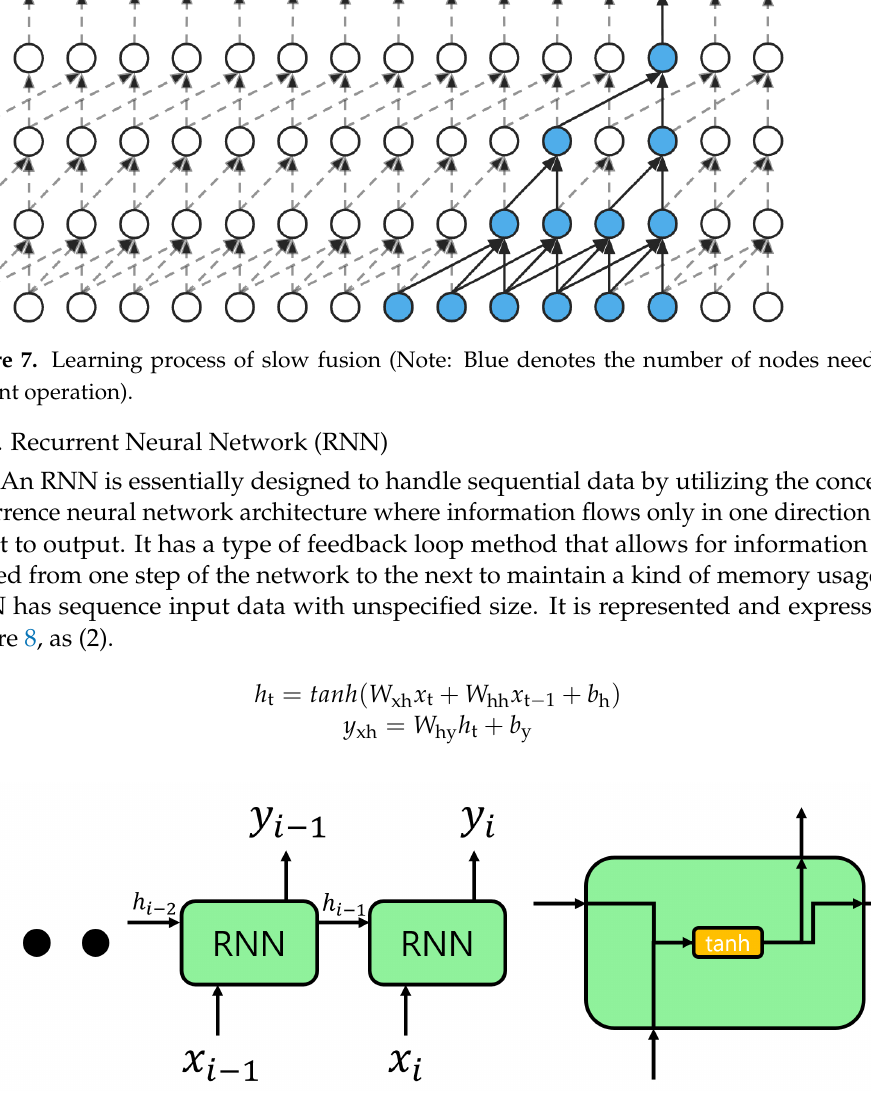
Figure 8. Learning process of